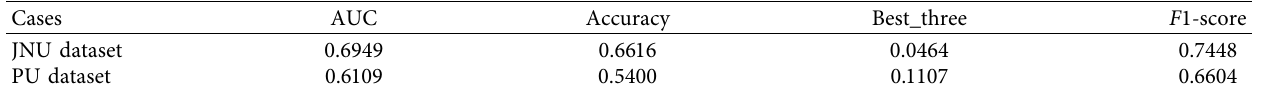
Figure 2: Anomaly detection of multiworking conditions based on VAE (JNU dataset with three working conditions). Table 1: Results of VAE-based anomaly